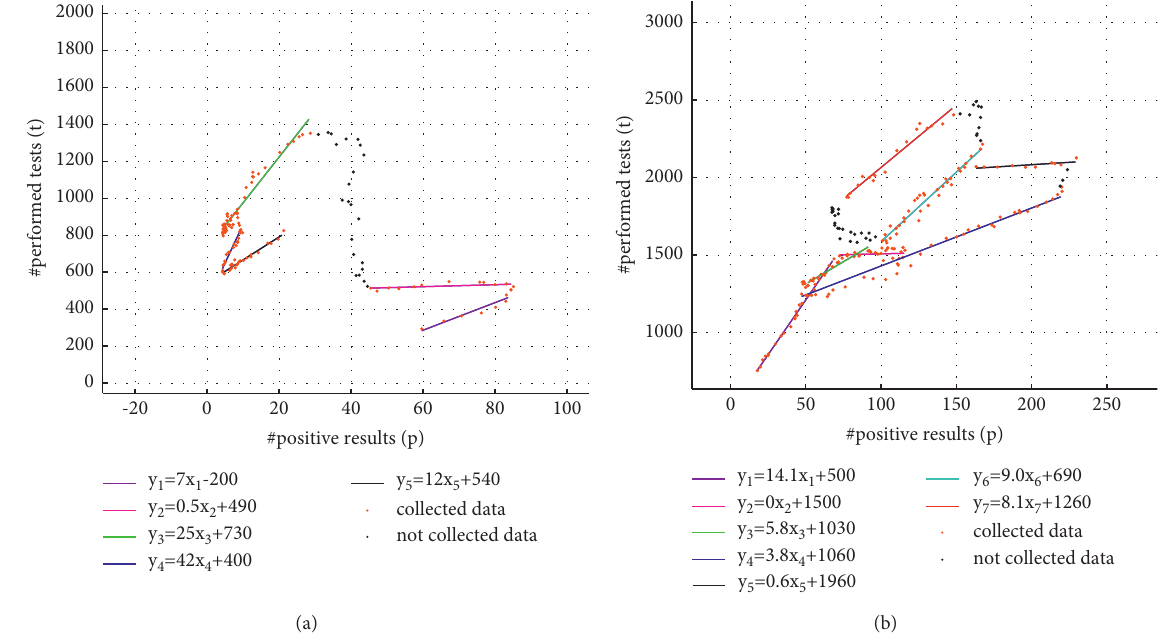
Figure 11: Linear regression of total tests versus positive tests in the periods of time from 01/03/2020 to 16/07/2020 (a) and from 17/07/2020 to 02/02/2021